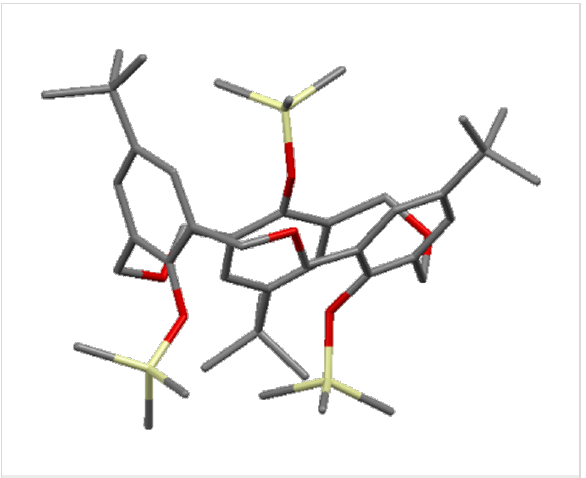
Figure 10: X-ray crystal structure of 27 in the partial-cone conformer (CCDC ID SUP 90399) [41].